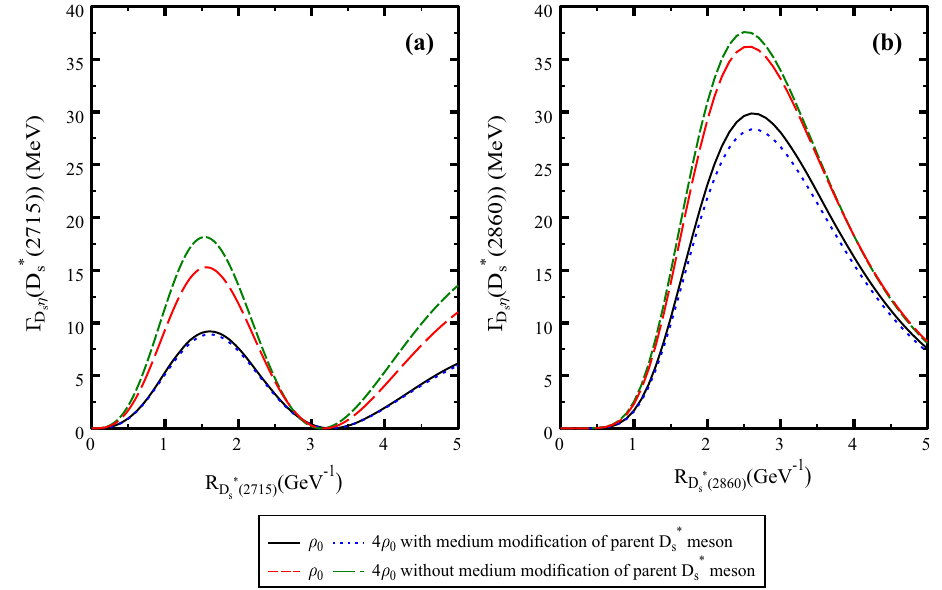
Fig. 8 Variation of partial decay width of the D ∗ s ( 2715 ) and D ∗ s ( 2860 ) mesons as a function of respective R A values with and without including the medium modified masses of D ∗ s ( 2715 ) and D ∗ s ( 2860 ) mesons